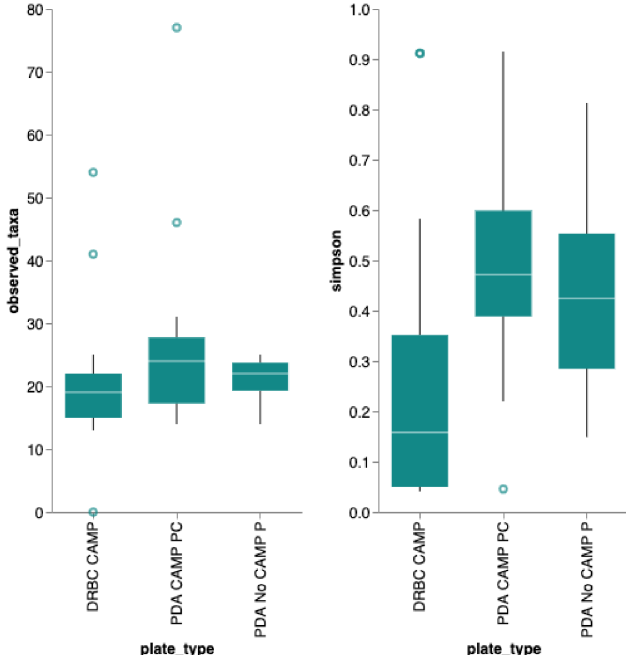
Figure 6. Simpson ’ s Diversity Index. Simpson ’ s diversity index (https://geographyfieldwork.com/Simpson%27sDi- versityIndex.htm)isusedtoquantifythebiodiversityofahabitatona0to1scale.Ittakesintoaccountthenumberof species present, as well as the relative abundance of each species. A diversity index of 1 represent infinite diversity where 0 reflects no diversity. Dichloran Rose Bengal (DRBC) plating demonstrates the lowest diversity. This is not surprising given DRBC contains 3 different selection agents. While this limits bacterial contamination it also limits yeast and mold growth.